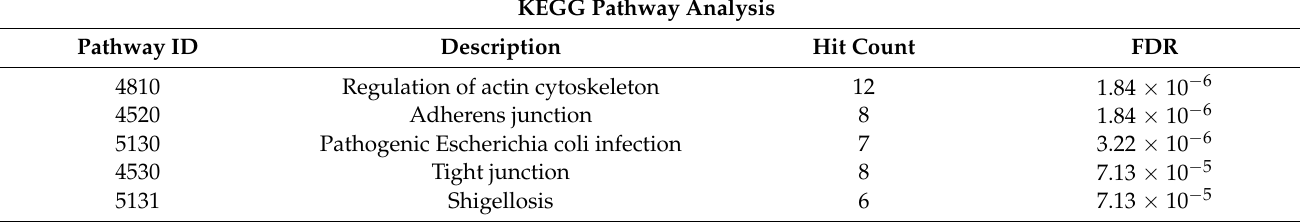
Table 1. Top five best-represented KEGG pathways among the NIS plasma membrane interactors described in [10]. The analysis was performed using STRING algorithm (https://string-db.org/, accessed on 5 October